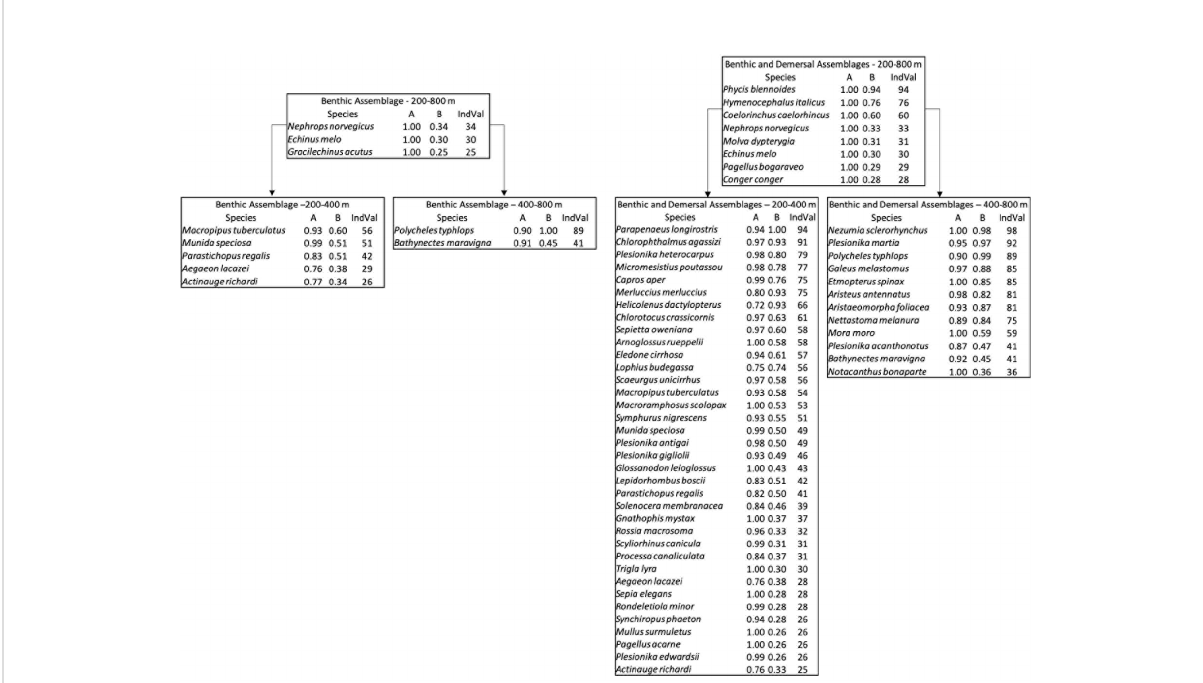
FIGURE 4 Characteristic species of the deep-sea assemblages (benthic on the left; benthic and demersal on the right) identi fi ed by means of the Individual Value index (IndVal) in each group, with indication of speci fi ty column (A) and fi delity column (B) . Only species with IndVal >25 are